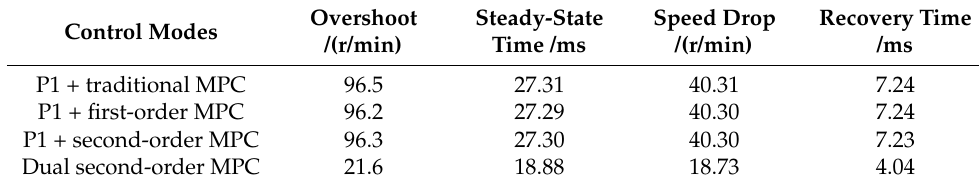
Figure 6. Torque response of four control modes. Table 3. Performance comparison of the four control